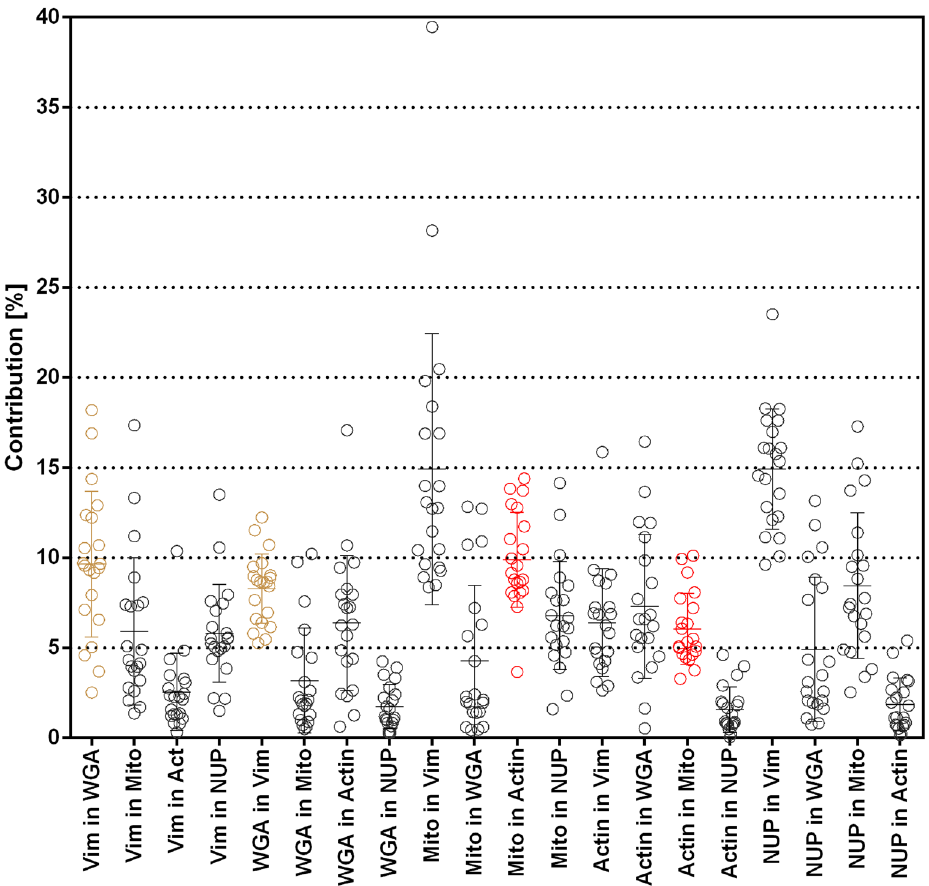
Figure 8. Contribution values for spectrally and lifetime separated signals in five color FLIM-STED images, n = 21 image sets. Channels generated by phasor separation from the same raw images are shown in the same color, all others in black. Note that “contribution” is normalized to signal intensities (see “Methods”). The non- normalized bleed-through is shown in Supplemental Fig.